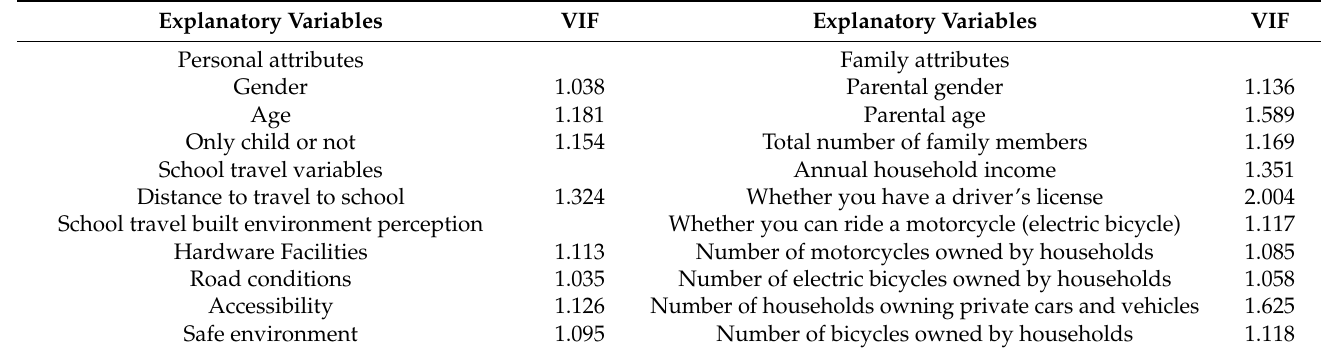
Table 4. Multicollinearity test.